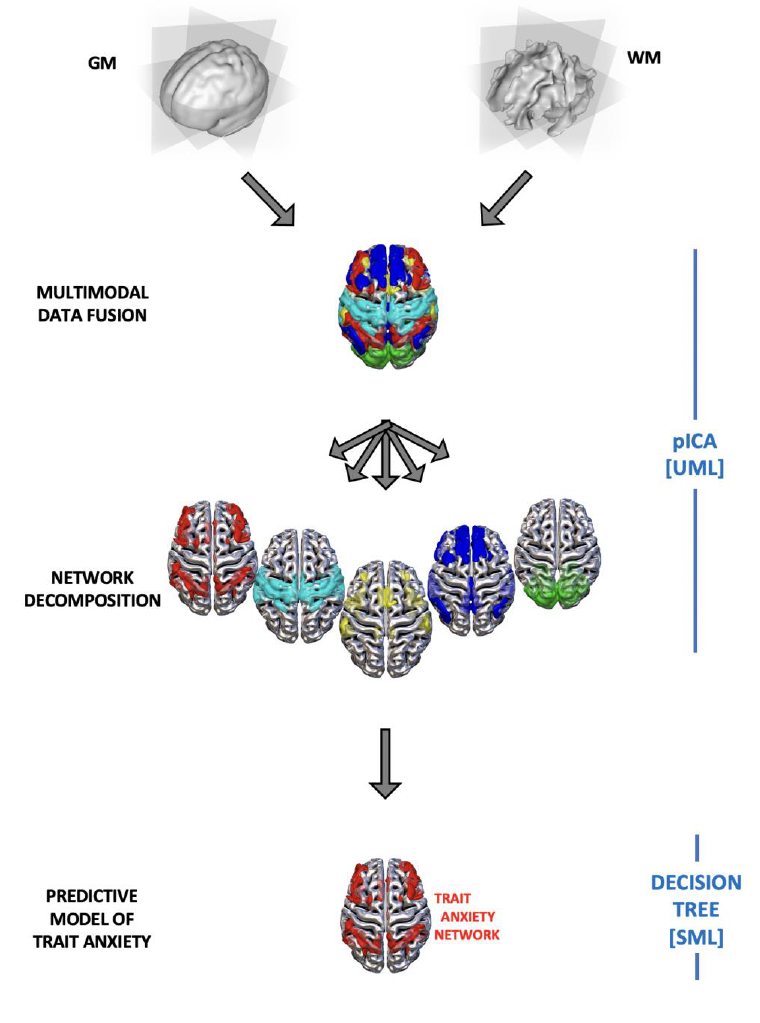
Figure 1. Combined data fusion machine learning approach. First unsupervised machine learning Parallel ICA (pICA) was used to combine the two modalities (gray and white matter) and to de- compose the brain into the covarying gray-white matter independent networks. Then supervised machine learning decision tree (DT) was used to predict anxiety traits scores.